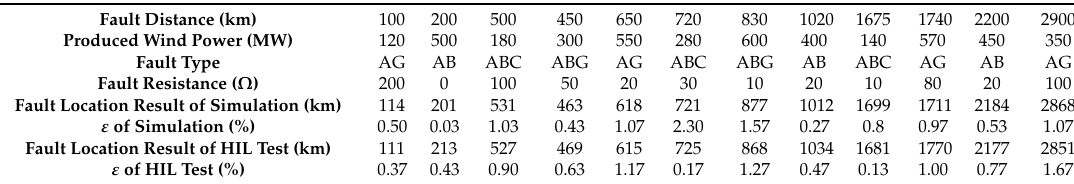
Table 9. Fault location results of simulation and HIL